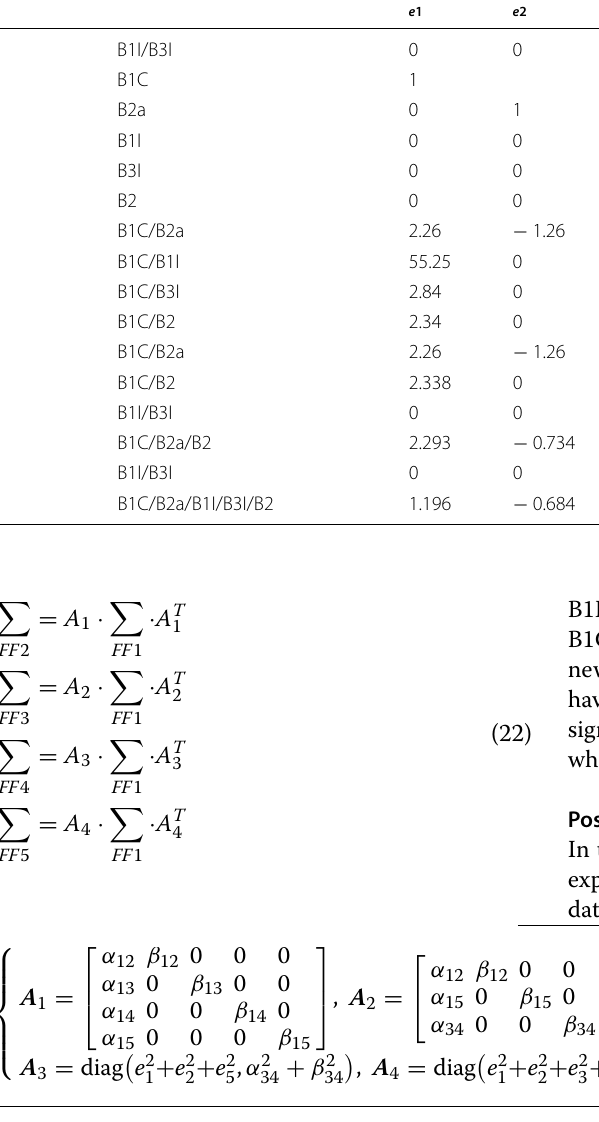
Table 2 Comparisons of the dual- and five-frequency PPP models Model